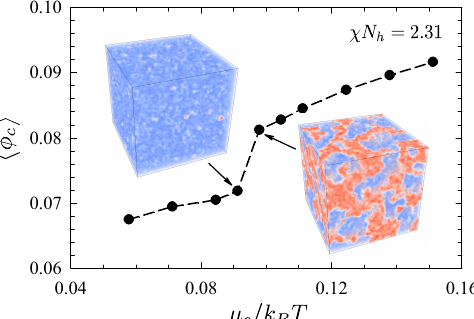
Figure 8. Average copolymer content in the ternary blends as a function of chemical potential for χ N h = 2.31, obtained from grand-canonical FTS using cubic simulation boxes of size 72 R h . Adapted from Ref.